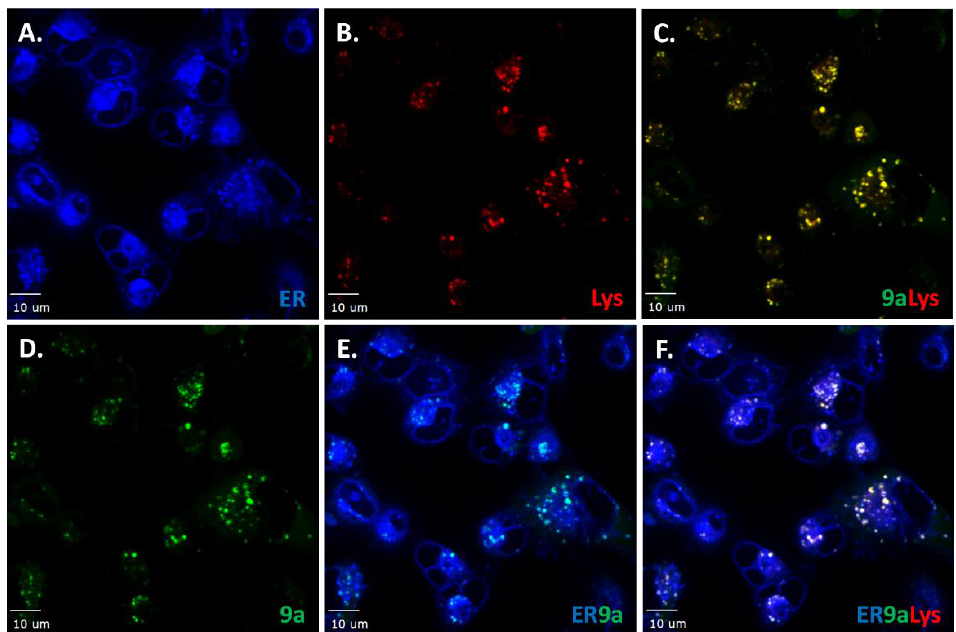
Figure 8. Representative images of co-localization studies of probe 9a with organelle fluorescent stains in live cells. A. ER tracker Blue/White (blue). B. Lysosome tracker (red). C. Merged image of lysosomal and probe 9a staining. D. Probe 9a (2 µM, green). E. Merged image of ER tracker and probe 9a staining. F. Merged image of ER tracker, Lysosome tracker and probe 9a staining. Scale bar: 10 μ m.